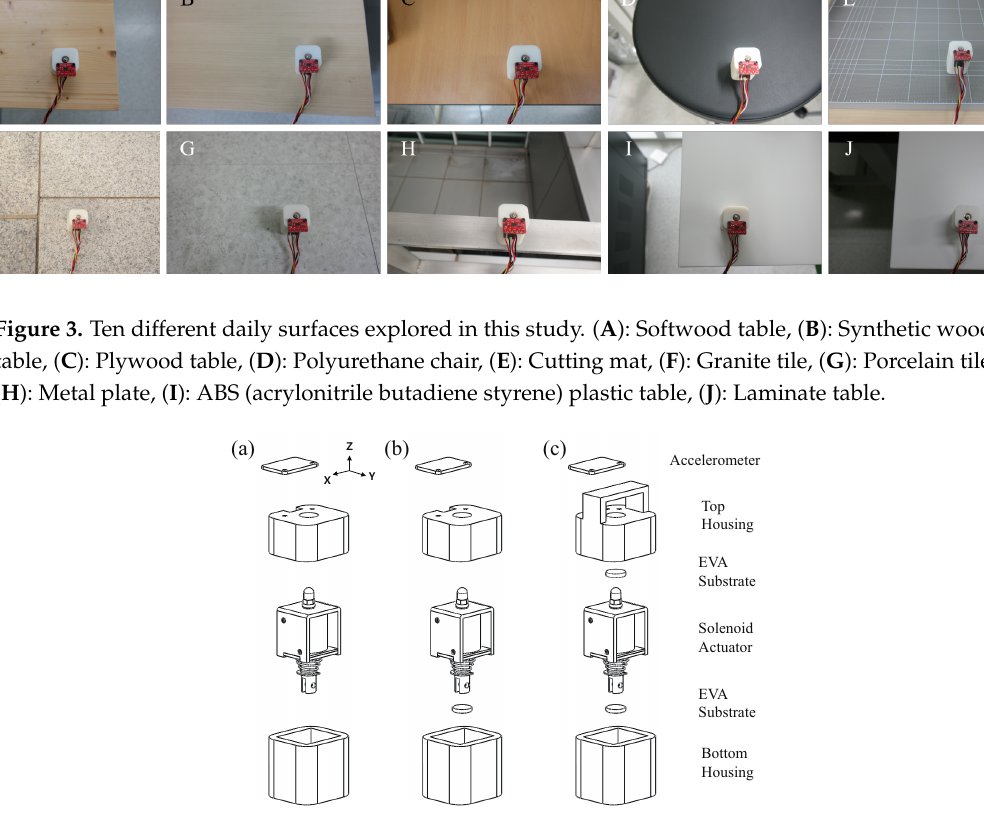
Figure 4. Three different hardware configurations used to collect the data samples. ( a ) The configuration described in Figure 1. We attached an ethylene vinyl acetate (EVA) substrate to ( b ) the bottom of the slug and ( c ) to the top and bottom of the slug, to diversify the characteristics of the loading motion, unloading motion, and resulting responses.